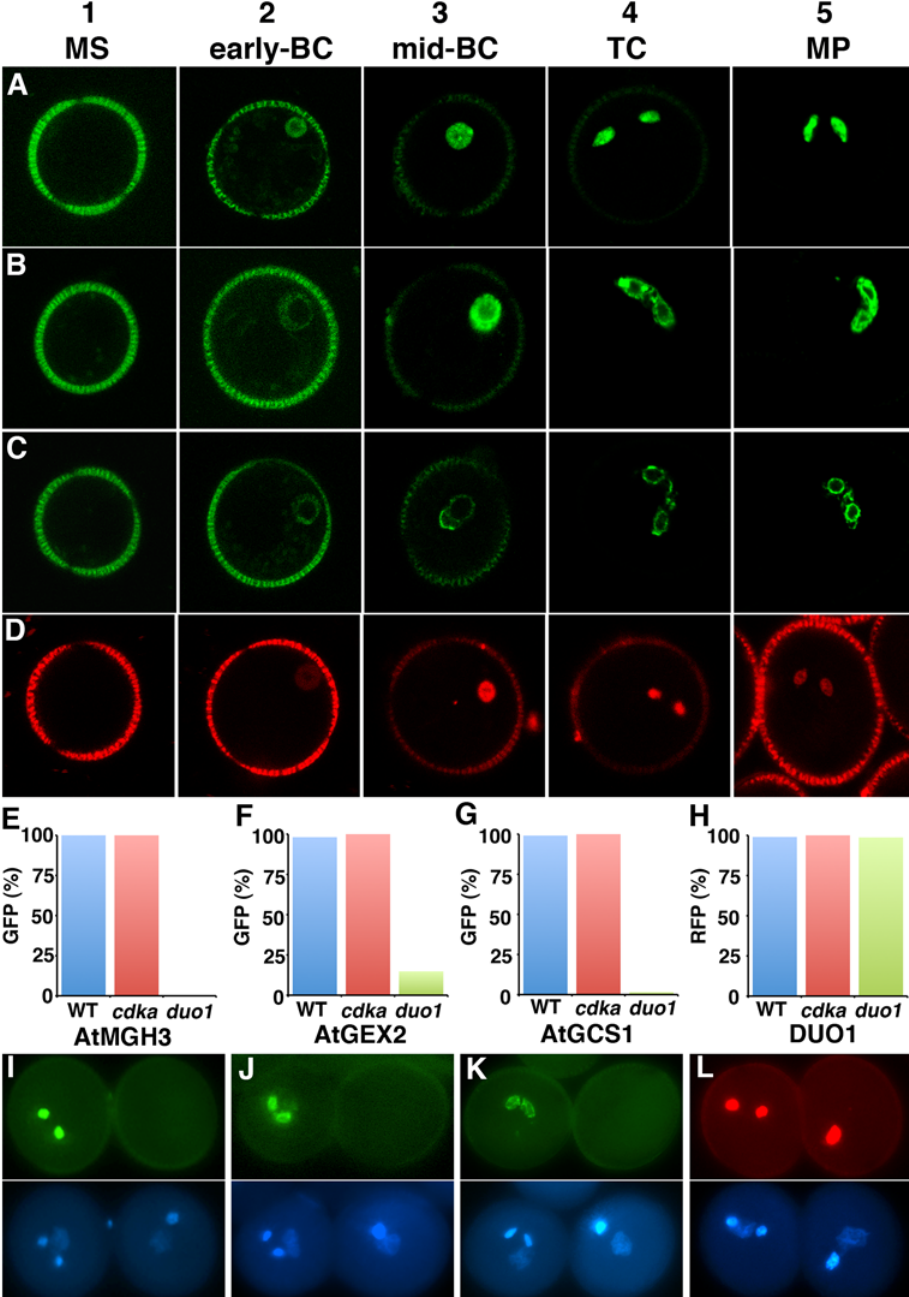
Figure 1. Expression of male germline-specific genes in wild type and duo1 pollen. Expression of AtMGH3-H2B::GFP (A), AtGEX2-GFP (B), AtGCS1-AtGCS1::GFP (C) and DUO1-DUO1::mRFP (D) during wild type pollen development, observed with CLSM. Panels are numbered 1 (left) to 5 (right). For all markers, fluorescence is not detected in microspores (MS; Panel 1), a weak signal is detected in the germ cell during or soon after engulfment (early-BC; Panel 2), fluorescence increases in mid-bicellular pollen (mid-BC; Panel 3) and remains in tricellular (TC; Panel 4) and mature pollen (MP; Panel 5). (E–L) Expression of germline expressed genes in heterozygous duo1 plants. The percentage pollen showing GFP or RFP in sperm cells of wild type (WT) pollen or the single germ cell in cdka;1 and duo1 mutant pollen in plants homozygous for AtMGH3-H2B::GFP (AtMGH3, E), AtGEX2-GFP (AtGEX2, F), AtGCS1-AtGCS1::GFP (AtGCS1, G) and DUO1-H2B::mRFP (DUO1, H). Individual examples viewed by fluorescence microscopy in I to L. AtMGH3-H2B::GFP (I), AtGEX2-GFP (J) and AtGCS1-AtGCS1::GFP (K) are not expressed, or have reduced expression in duo1 pollen while DUO1- H2B::RFP (L) is expressed. Each image has a wild type pollen grain to the left and a duo1 mutant grain to the right (see lower DAPI images).